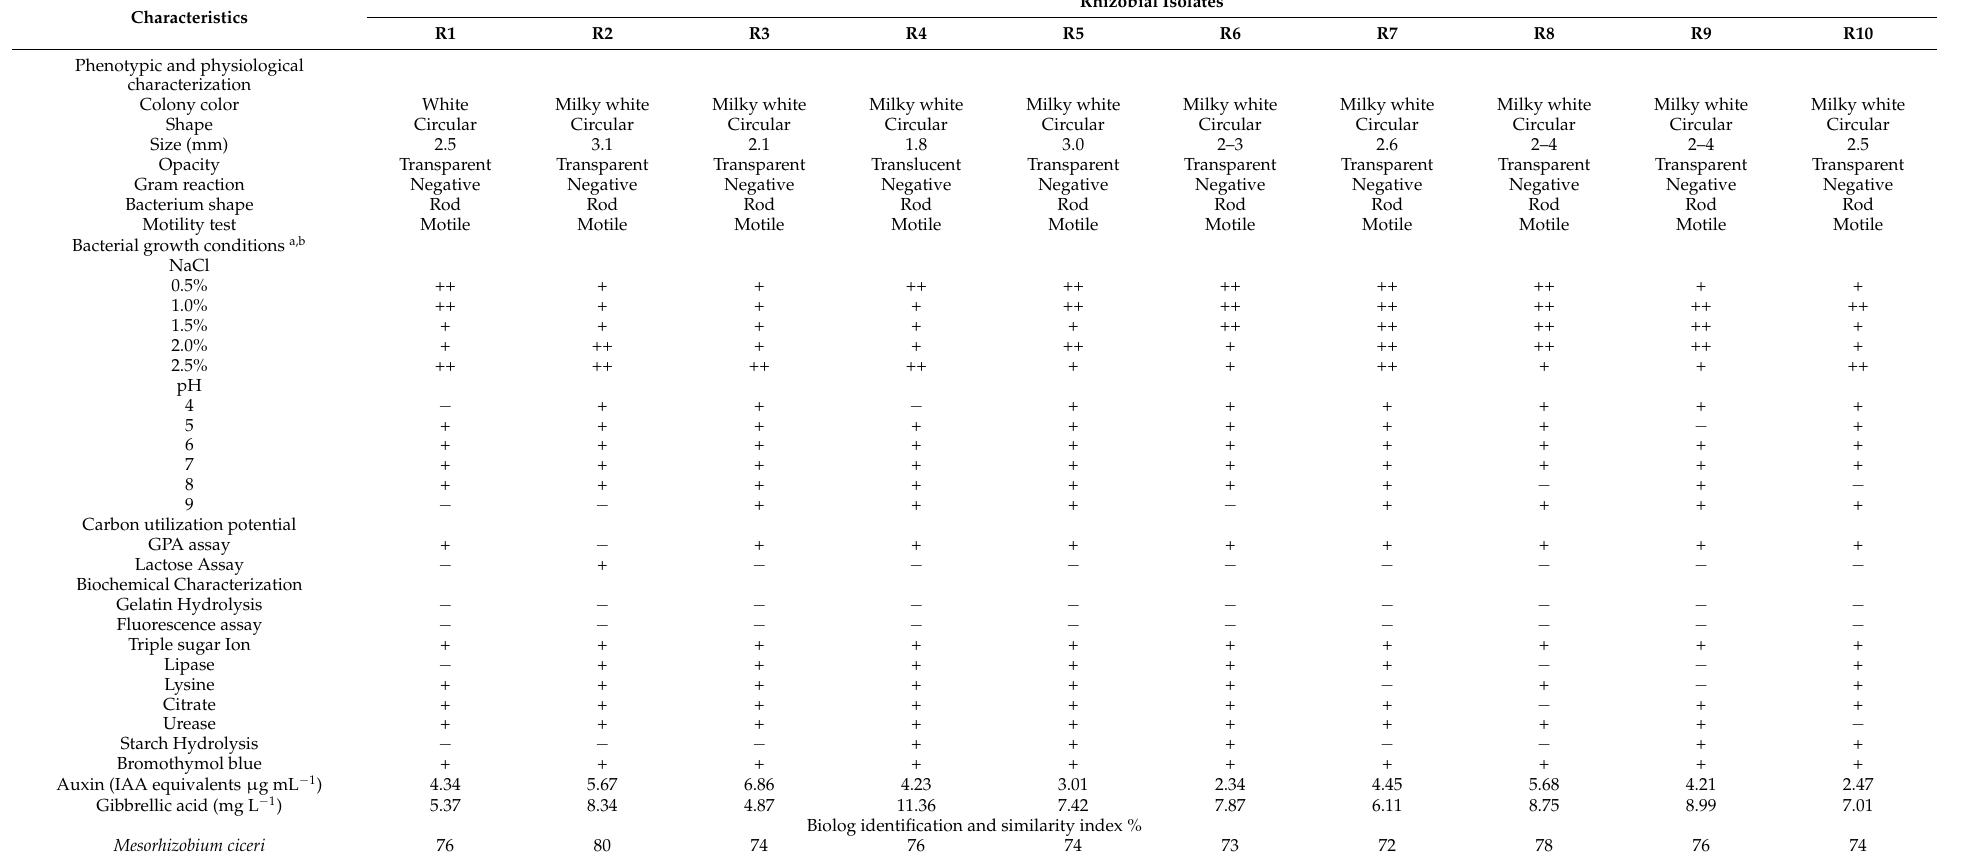
Table 1. Physiochemical and growth promoting parameters of